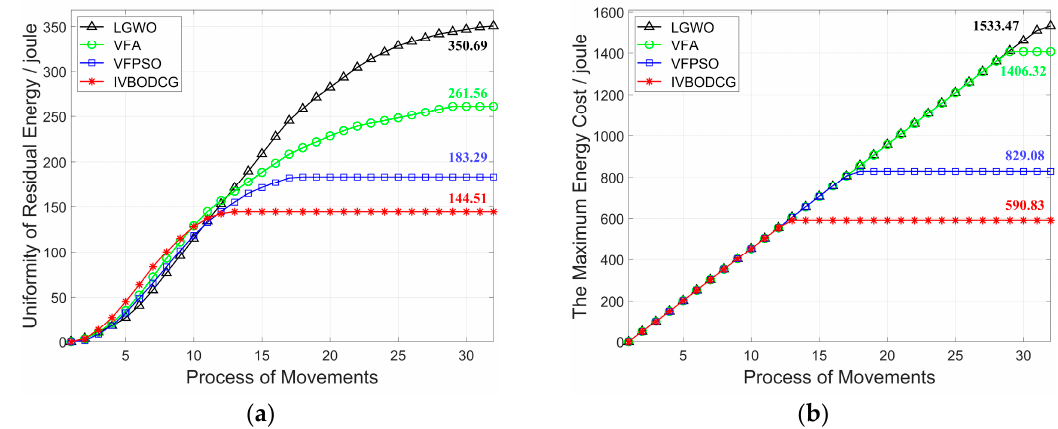
Figure 13. Comparison of MEC and URE of nodes of four algorithms. ( a ) shows the relationship between uniformity of residual energy and process of movements. ( b ) shows the relationship between the maximum energy cost and process of movements. Compared with LGWO, VFA and VFPSO, the IVBODCG’s MEC and URE is the best after the final round of movement.